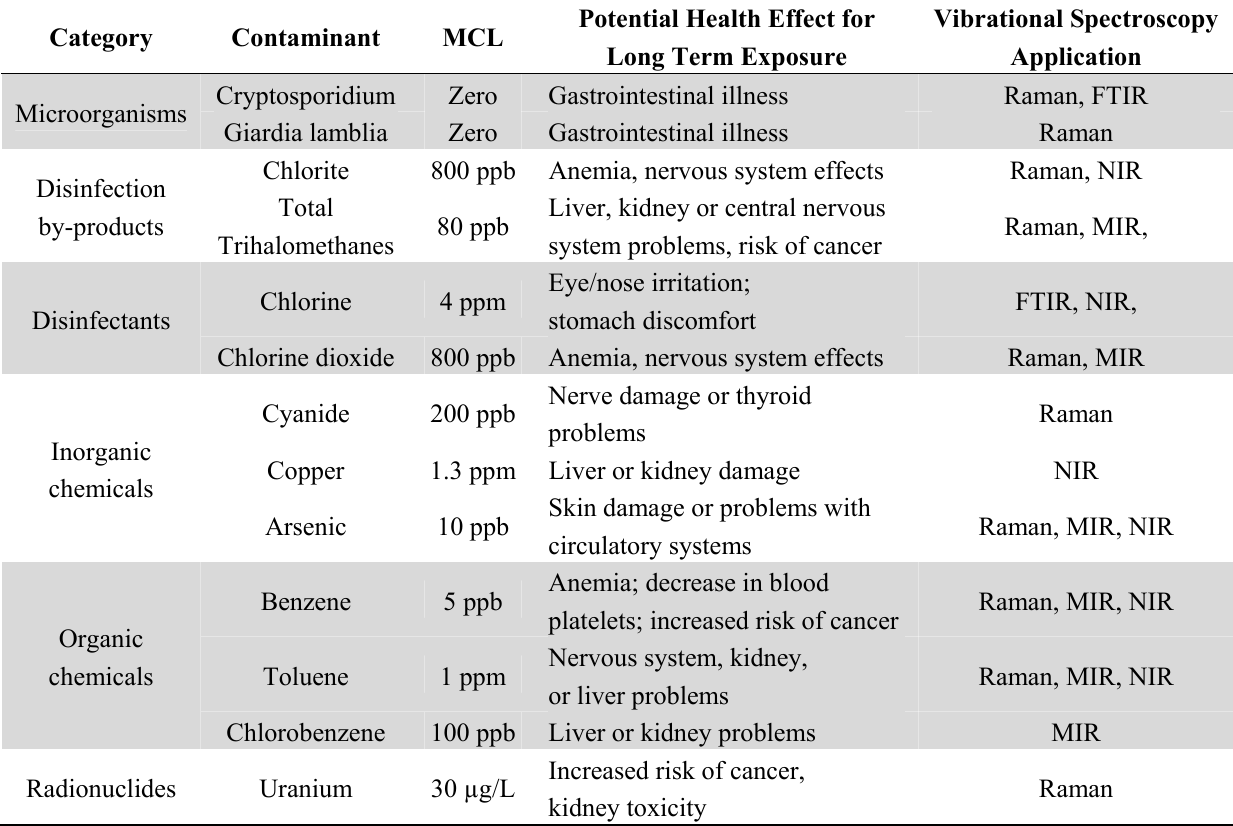
Table 1. List of water contaminants and the maximum contamination level (MCL) set by the US Environmental Protection Agency